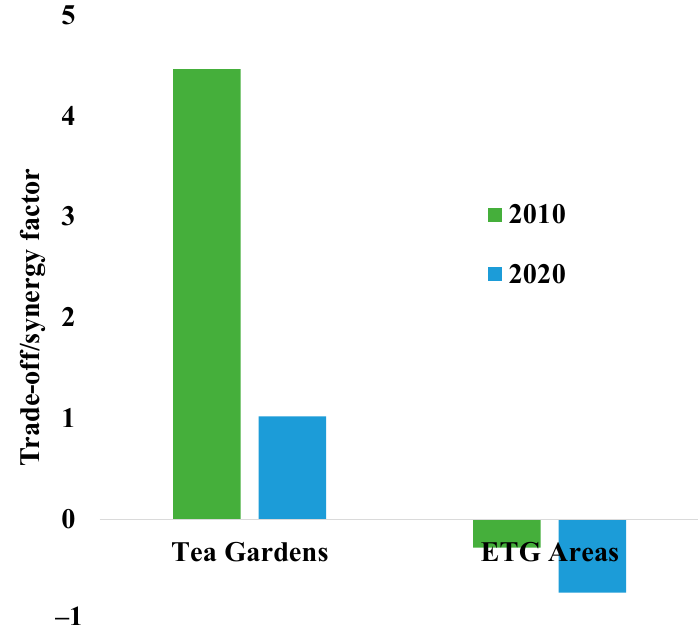
Figure 6. C ts in tea garden and ETG areas in Fuzhou.